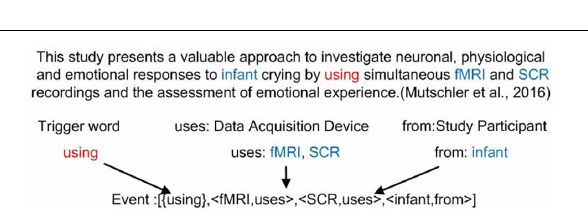
FIGURE 4 | An example of an “Acquisition” event from the article (Mutschler et al., 2016). This event consists of a trigger word “using,” two “Data Acquisition Device” category of arguments “fMRI” and “SCR,” and one “Study Participant” category of argument “infant.”